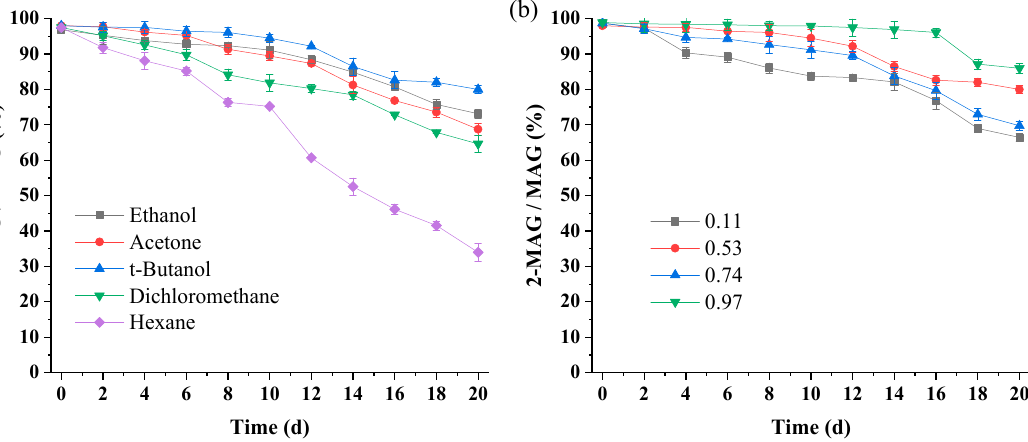
Figure 4. Acyl migration of 2-MAG in various solvents ( a ) and a w ( b ) at 30 °C for 20 days. Acyl migration conditions: ( a ) 0.7 g of purified 2-MAG, 7 mL of solvent, 0.3 g inactivated Lipozyme TL IM, a w of 0.53; ( b ) 0.7 g of purified 2-MAG, solvent of 7 mL t -butanol, 0.3 g inactivated Lipozyme TL IM. Acyl migration is a nucleophilic substitution reaction [40]. Negatively charged